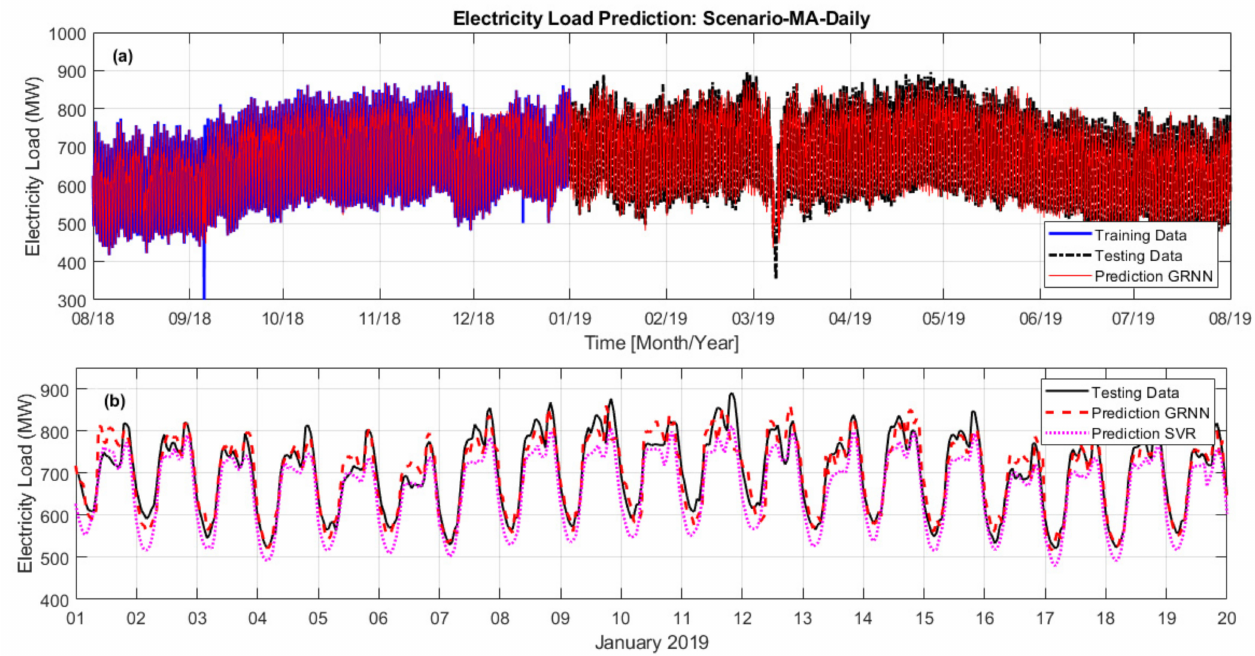
Figure 10. Comparison between electricity load testing data (solid black line) with results of prediction by using GRNN model (dashed red line), and SVR (dotted magenta line) for Scenario with MA-Daily; ( a ) during the period 1 January–1 August 2019; ( b ) during the period 1–20 January